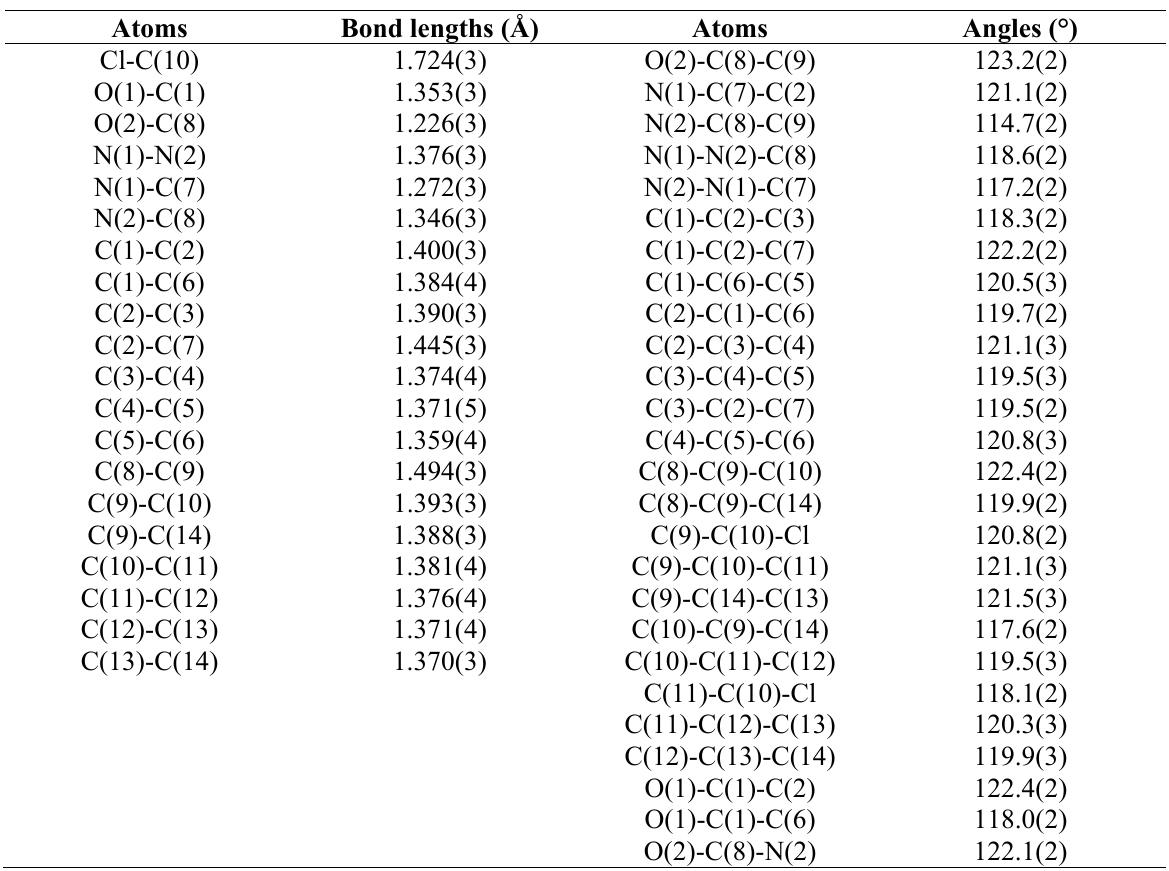
Table 2. Bond lengths [Å] and angles [°] for salicylaldehyde 2-chlorobenzoyl hydrazone (H 2